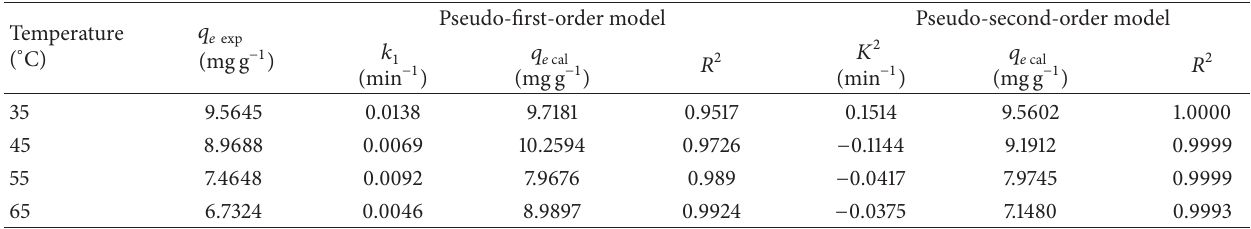
Table 4: Pseudo-first-order and pseudo-second-order rate constants for different temperatures. Conditions as in Table 2 except temperature.